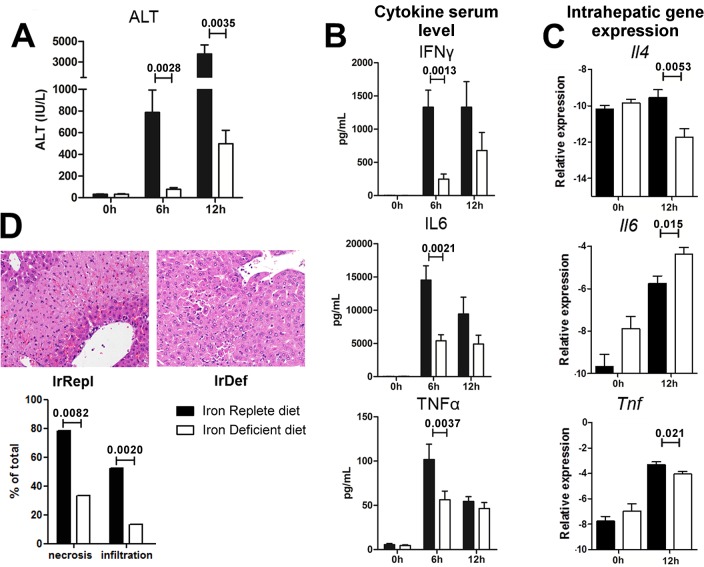
Iron deficiency results in attenuated immune-mediated hepatitis following ConA administration.(A) Serum levels of alanine aminotransferase (ALT; IU/mL) before, 6 hours and 12 hours after administration of ConA in mice fed for 3 weeks with an iron deficient (IrDef) or iron replete (IrRepl) diet. (B) Cytokine levels in serum samples collected before, 6 hours and 12 hours after the administration of ConA. (C) Transcript levels of Il4, Il6 and TNFα in liver tissue samples collected before and 12 hours after the administration of ConA. (D) Representative liver histology (200x) at 12 hours after the administration of ConA (upper panel) and histologic evaluation of necrosis and infiltration (lower panel).